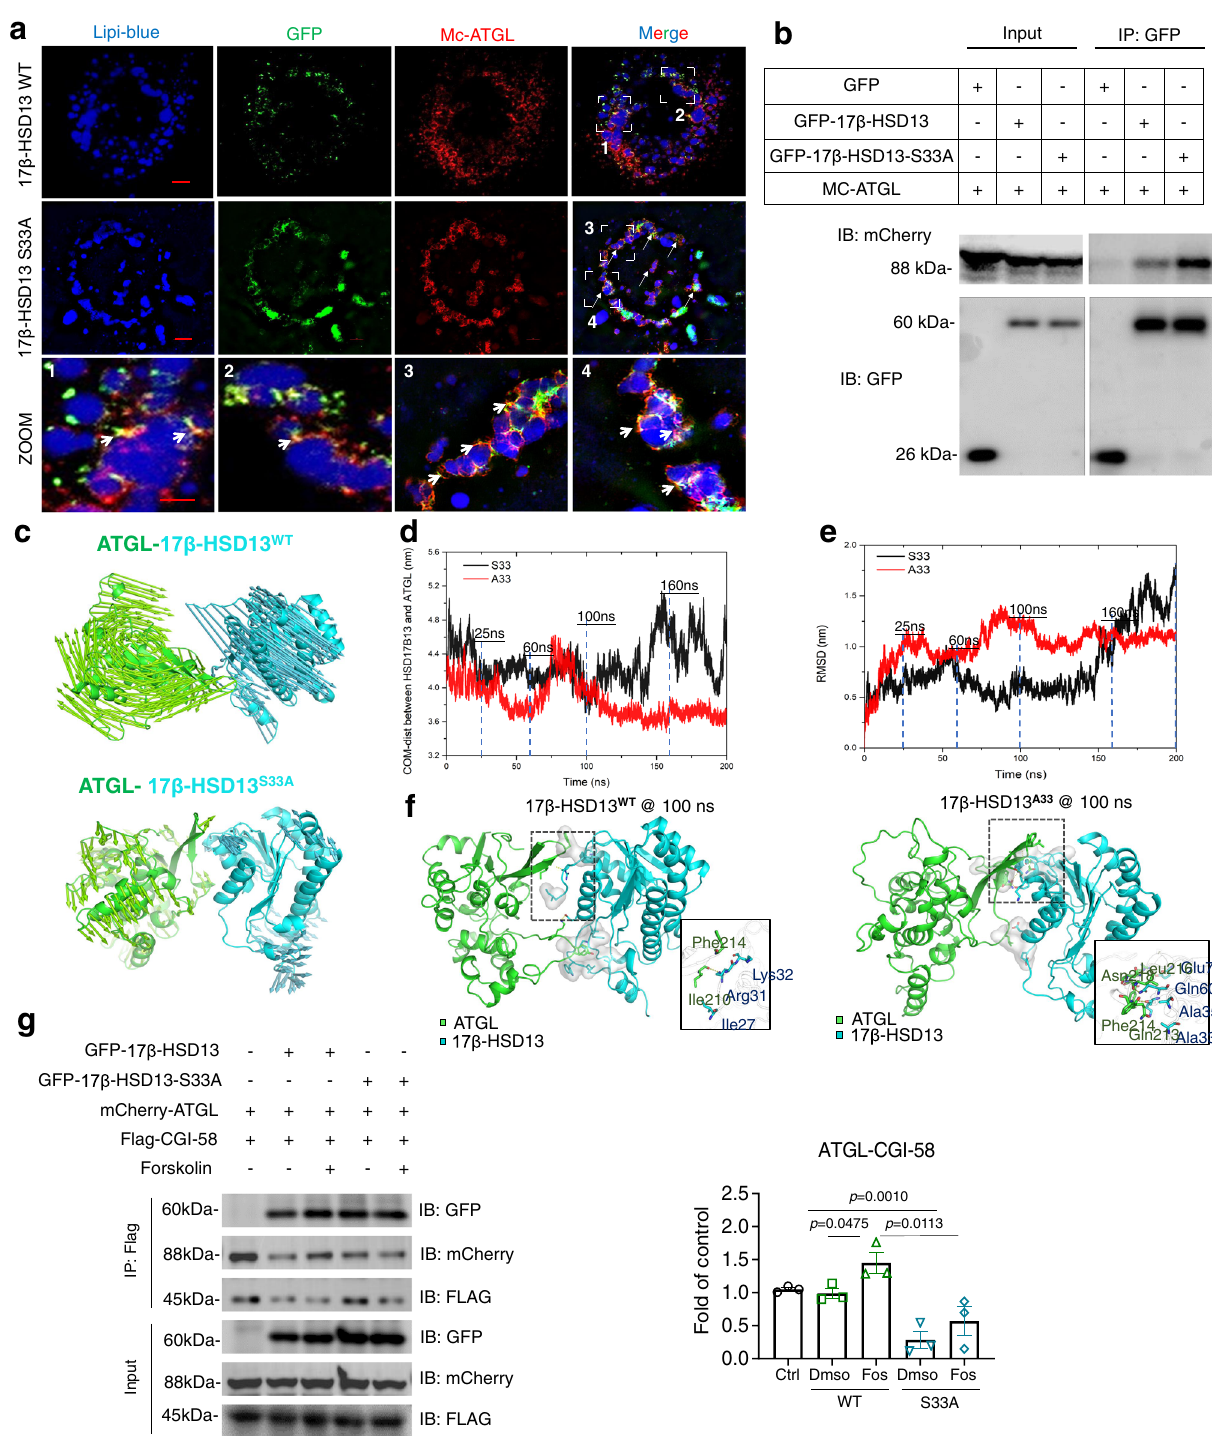
CGI-58 in 17 β -HSD13 WT-expressing cells with little effect in the cells expressing 17 β -HSD13 S33A mutant (Fig. 5g). Together, these observations indicate that PKA-mediated Ser33 phosphorylation of 17 β -HSD13 increases, while the PKA-targeted S33 residue-disrupted 17 β -HSD13 S33A mutation ameliorates, the binding of ATGL to